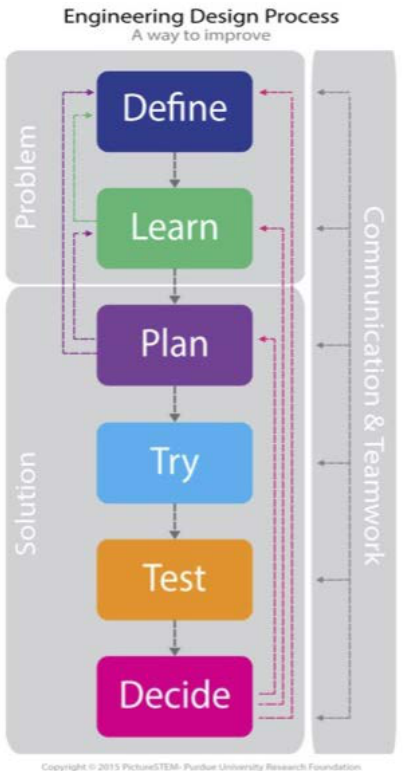
Figure 1. Engineering Design